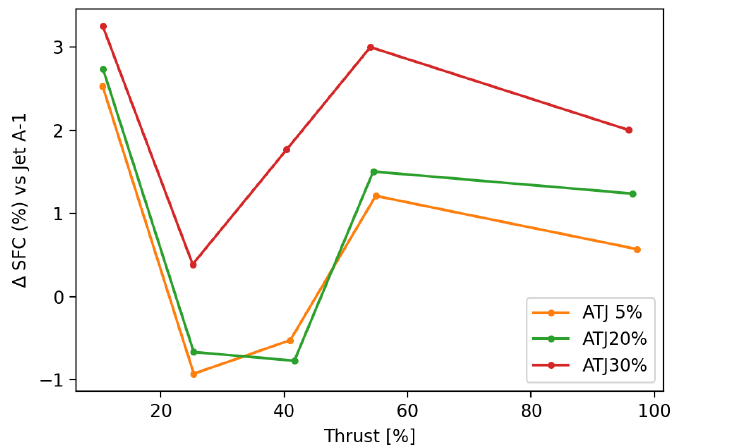
Figure A1. DGEN 380/ATJ: SFC changes.